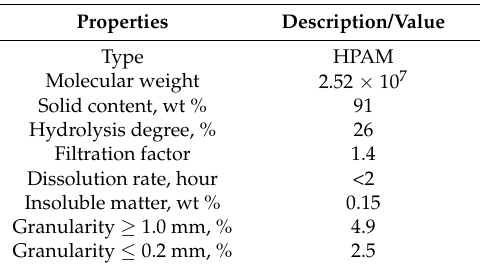
Table 1. Polymer properties.